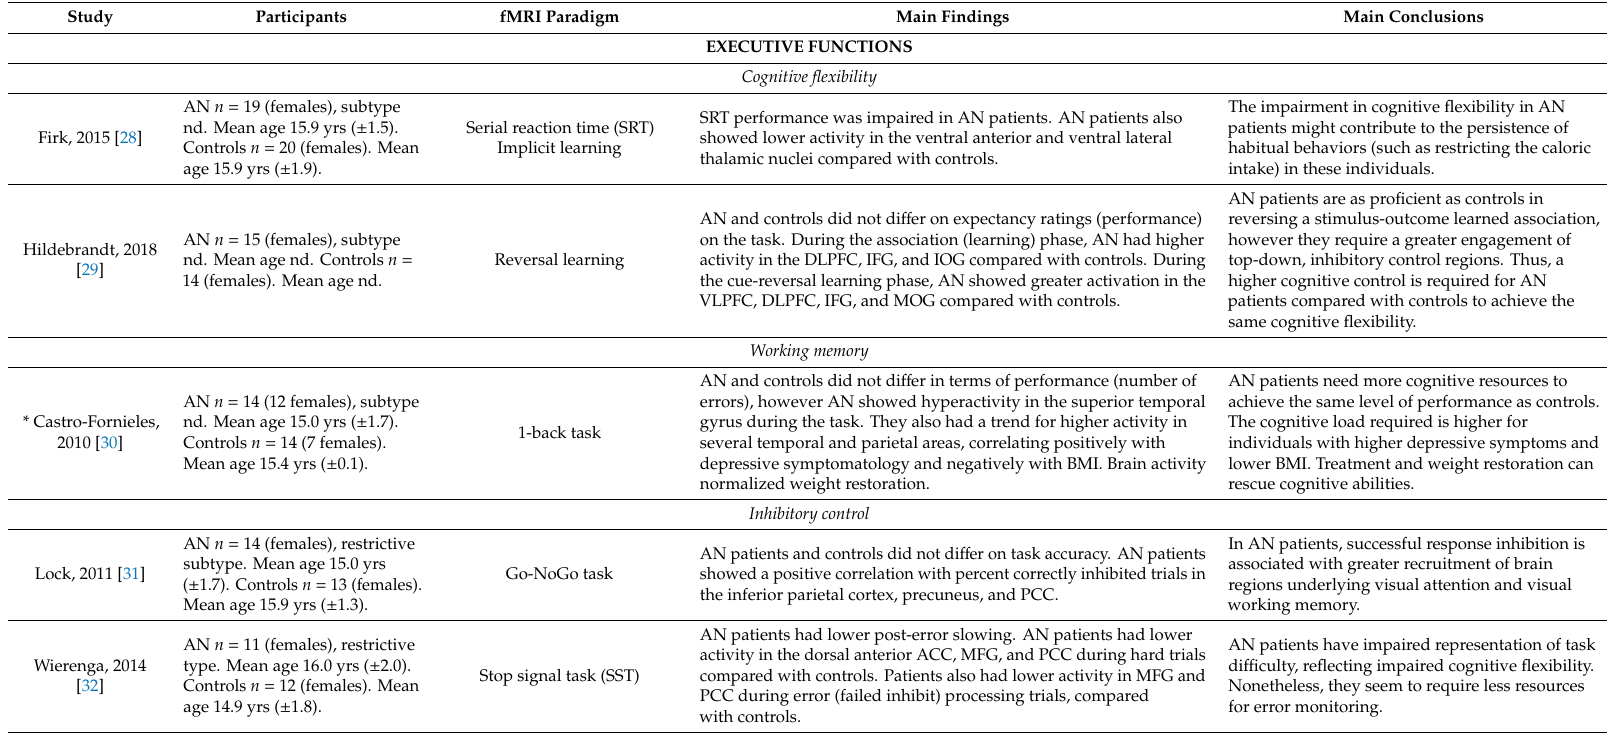
Table 1. Main results from the selected